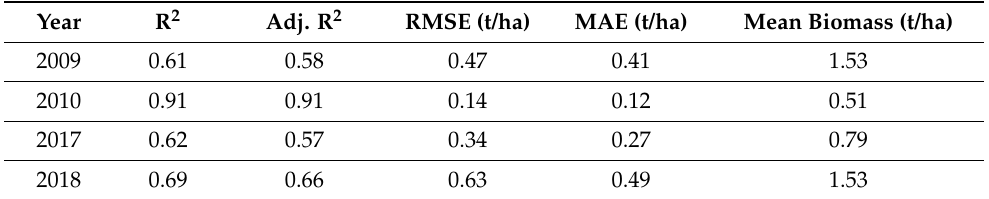
Table 9. Performance metrics of the linear models linking alfa steppes biomass and ARVI for the years 2009, 2010, 2017, and